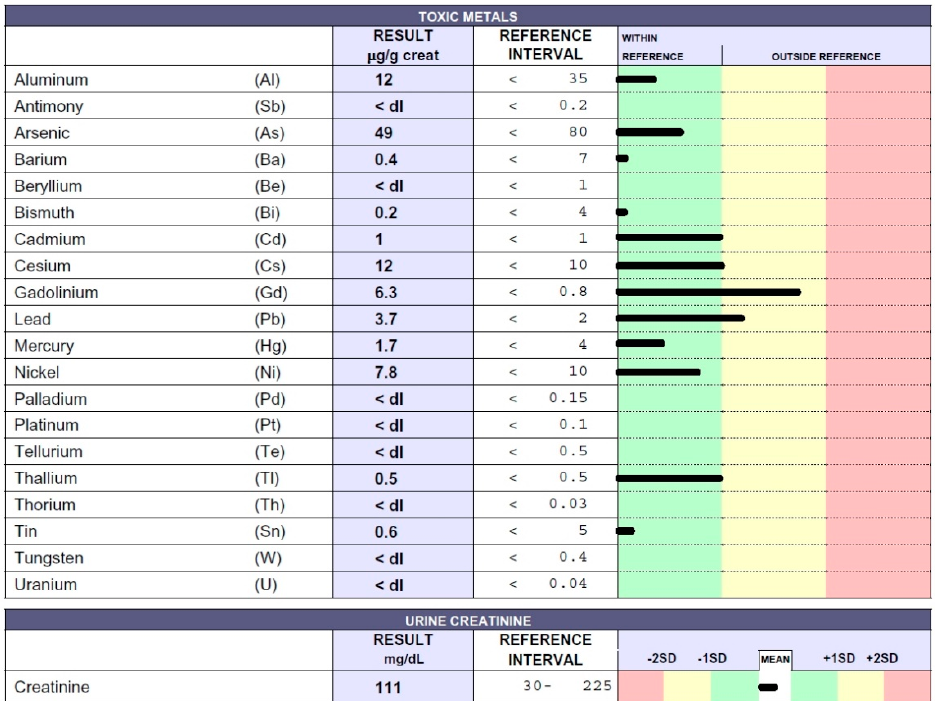
Figure 5. Toxic metal levels measured by ICP-MS method in the patient’s urine collected during the 12 h following EDTA chelation test reported in micrograms (µg) per g creatinine. The patient underwent chelation therapies with EDTA for a year and was affected by MS.